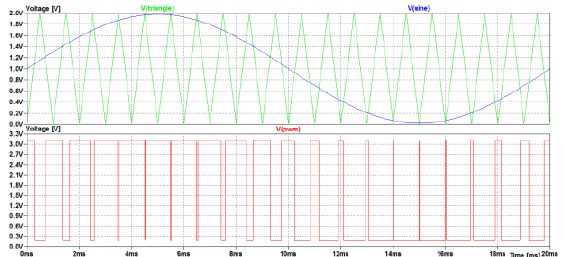
Fig. 1. I ntersective method to generate the PWM train corresponding to given